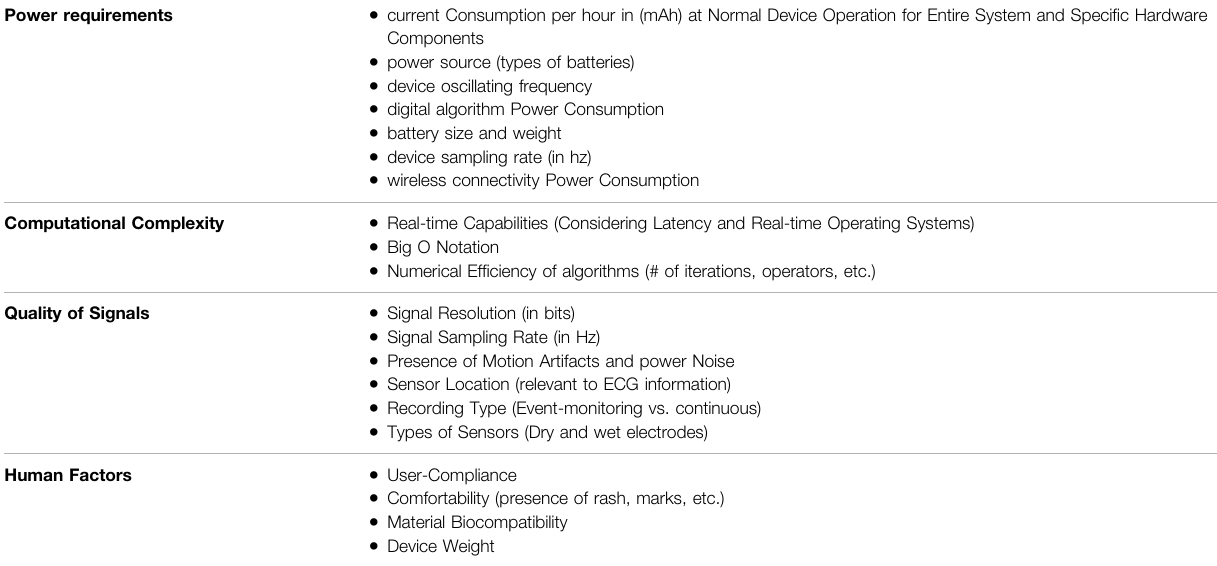
TABLE 2 | Single-lead ECG monitoring design considerations checklist. Power